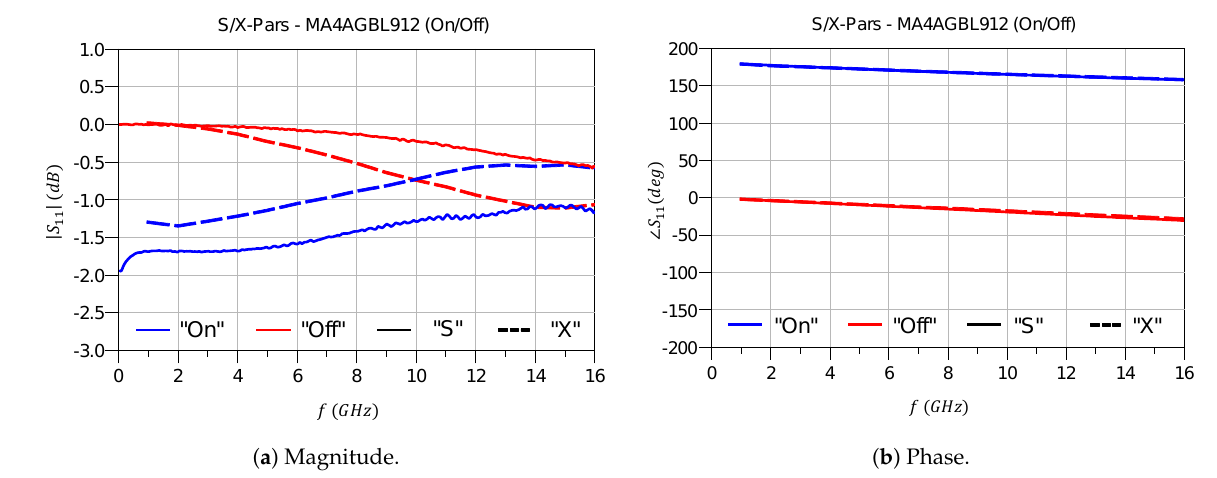
Figure 5. S - and X - parameters small signal convergence.